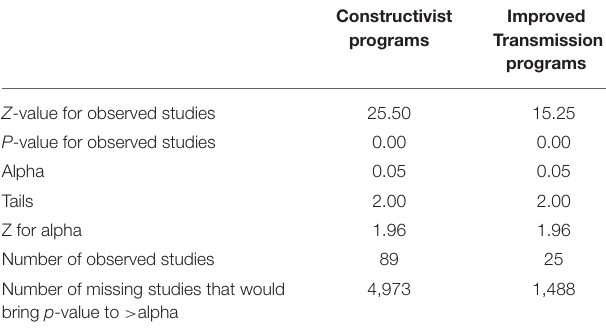
TABLE 3 | Classic fail-safe N